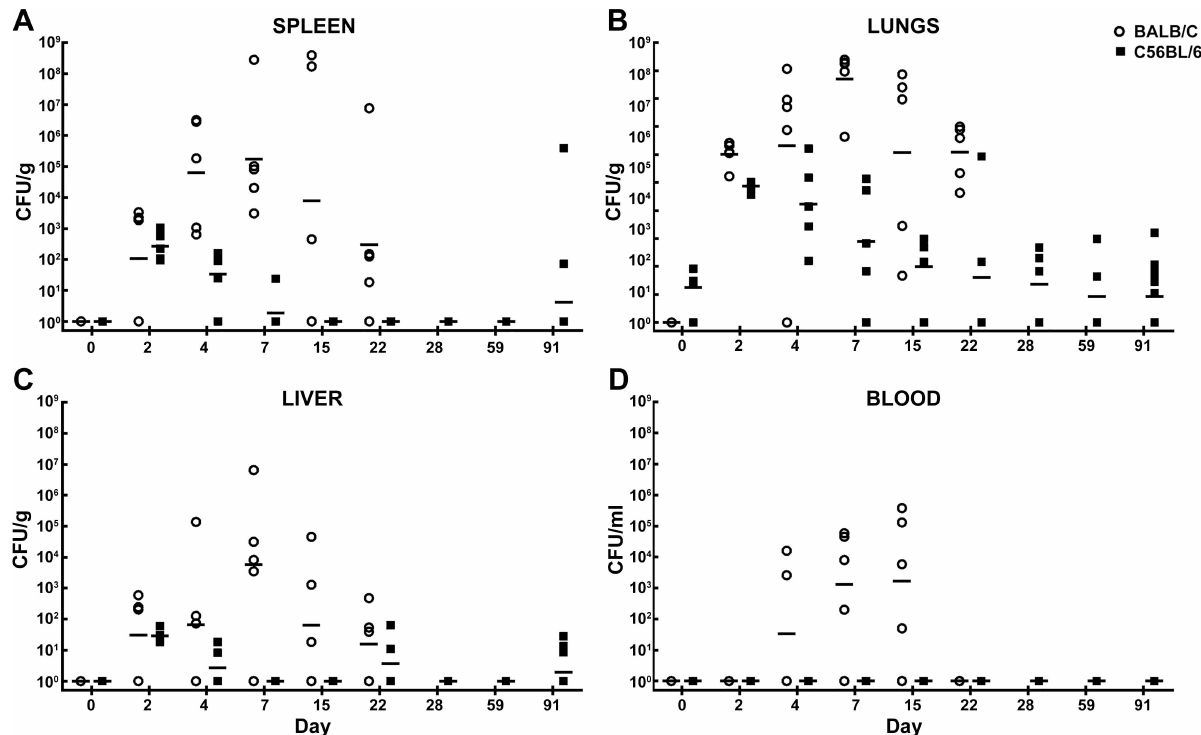
Fig 8. Bacterial burden determined in mice exposed to aerosolized B . pseudomallei K96243. CFU/g for spleen (A) , lungs (B) , liver (C) and CFU/ml for blood (D) are depicted.The geometric mean for each group is indicated. BALB/C mice are depictedwith opencircles and C57BL/6 mice are depictedwith filled squares. N = 5 at each time point through day 22 for both mouse strains. The survivingBALB/c mice after day 22 were used to perform histopathologicalanalyses. N = 12 for survivingC57BL/6mice on day